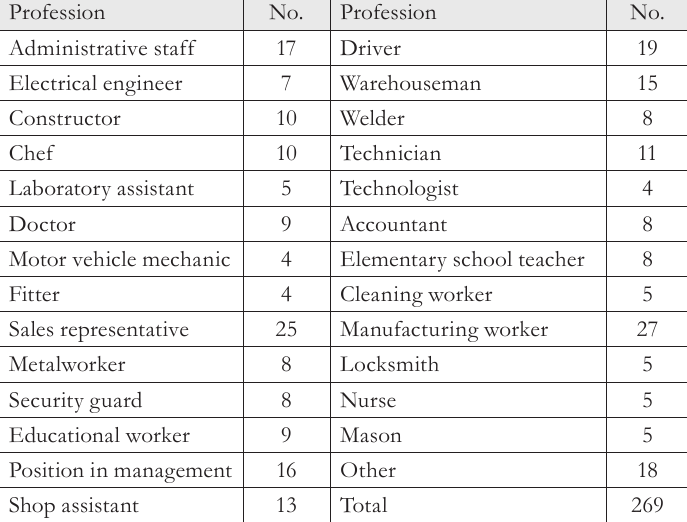
Tab. 3 - Categories of professions. Source: own